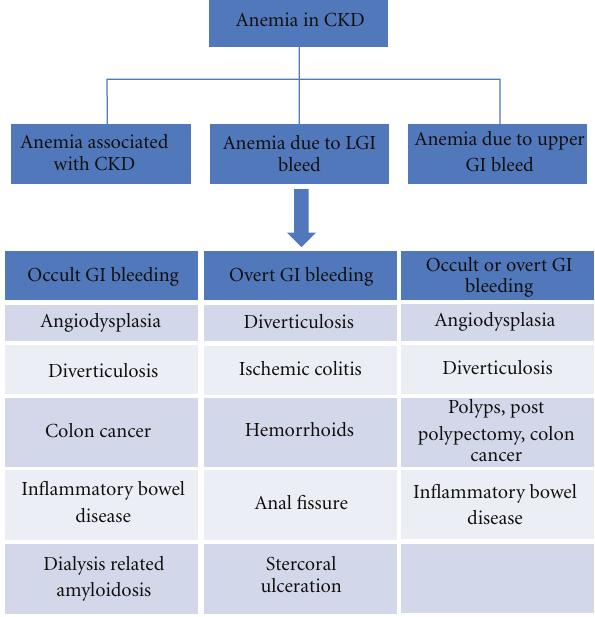
Figure 2: Causes of LGI bleeding in CKD